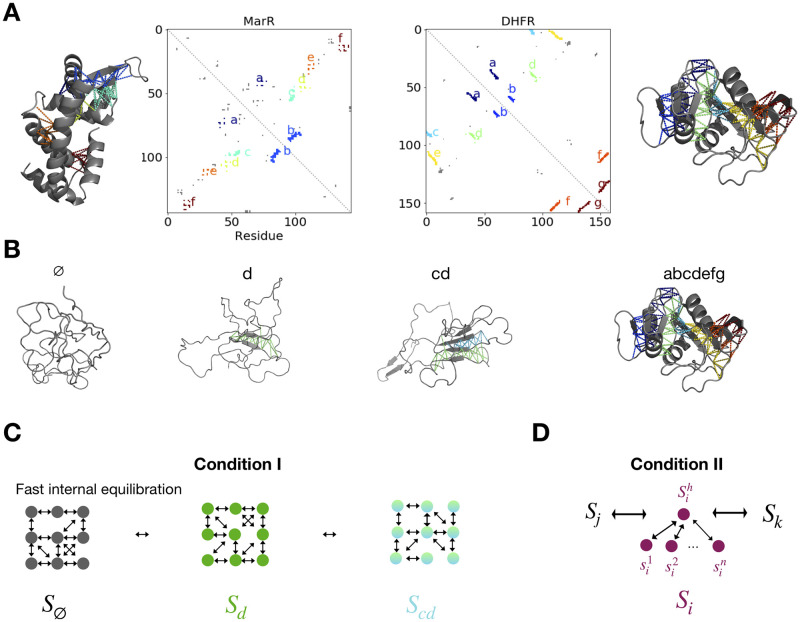
Coarse-graining the folding landscape.Examples of native contact maps alongside native structures with highlighted substructures (islands of continuous native contacts, see main text and Materials and methods) for the E. Coliproteins MarR (left) and DHFR (right). Substructures are labeled alphabetically. Native contacts not assigned to a substructure are shown in gray on the contact maps. We note that, for brevity and ease of visualization, we omit contacts involving residues less than 8 amino acids apart in sequence (and thus intra-helical contacts are excluded). (B) Sample topological configurations, alongside representative simulation snapshots for DHFR are shown. A snapshot is assigned to a given topological configuration if it contains a certain subset of folded native substructures (indicated by the labels above, see Materials and methods for details regarding the assignment process), and configuration ∅ includes snapshots with no folded native substructures. (C-D) Schematic illustrations of conditions I (C) and II (D) under which a detailed-balance like relationship can be used to compute folding rates between topological configurations given equilibrium probabilities (from enhanced sampling) and unfolding rates (from high-temperature simulations). Circles represent microstates consistent with a given coarse-state, which may contain nonnative contacts, while double-arrows represent transitions. For details on these conditions, see the main text.